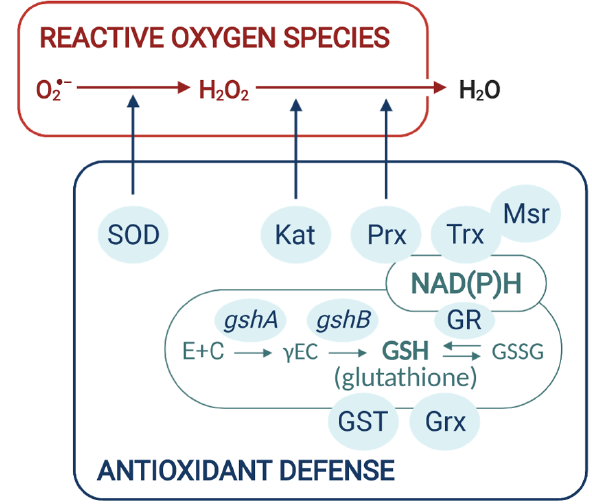
Figure 2. General bacterial antioxidant defense. Bacteria protect themselves from ROS thanks to enzymes (SOD: superoxide dismutase; Kat: catalase; Px: peroxidase; Prx: peroxiredoxin; Trx: thioredoxin; Msr: methionine sulfoxide reductase) and low molecular weight thiol glutathione (GSH). GSH can be used by glutathione-S-transferase (GST) or glutaredoxin (Grx) to detoxify ROS. Glutathione reductase (GR) allows the regeneration of GSH from the oxidized form GSSG. Grx works with Trx in order to reduce protein disulfides, and Msr reduces methionine sulfoxide residues to methionine. GR, Trx, and Msr use NAD(P)H as an electron